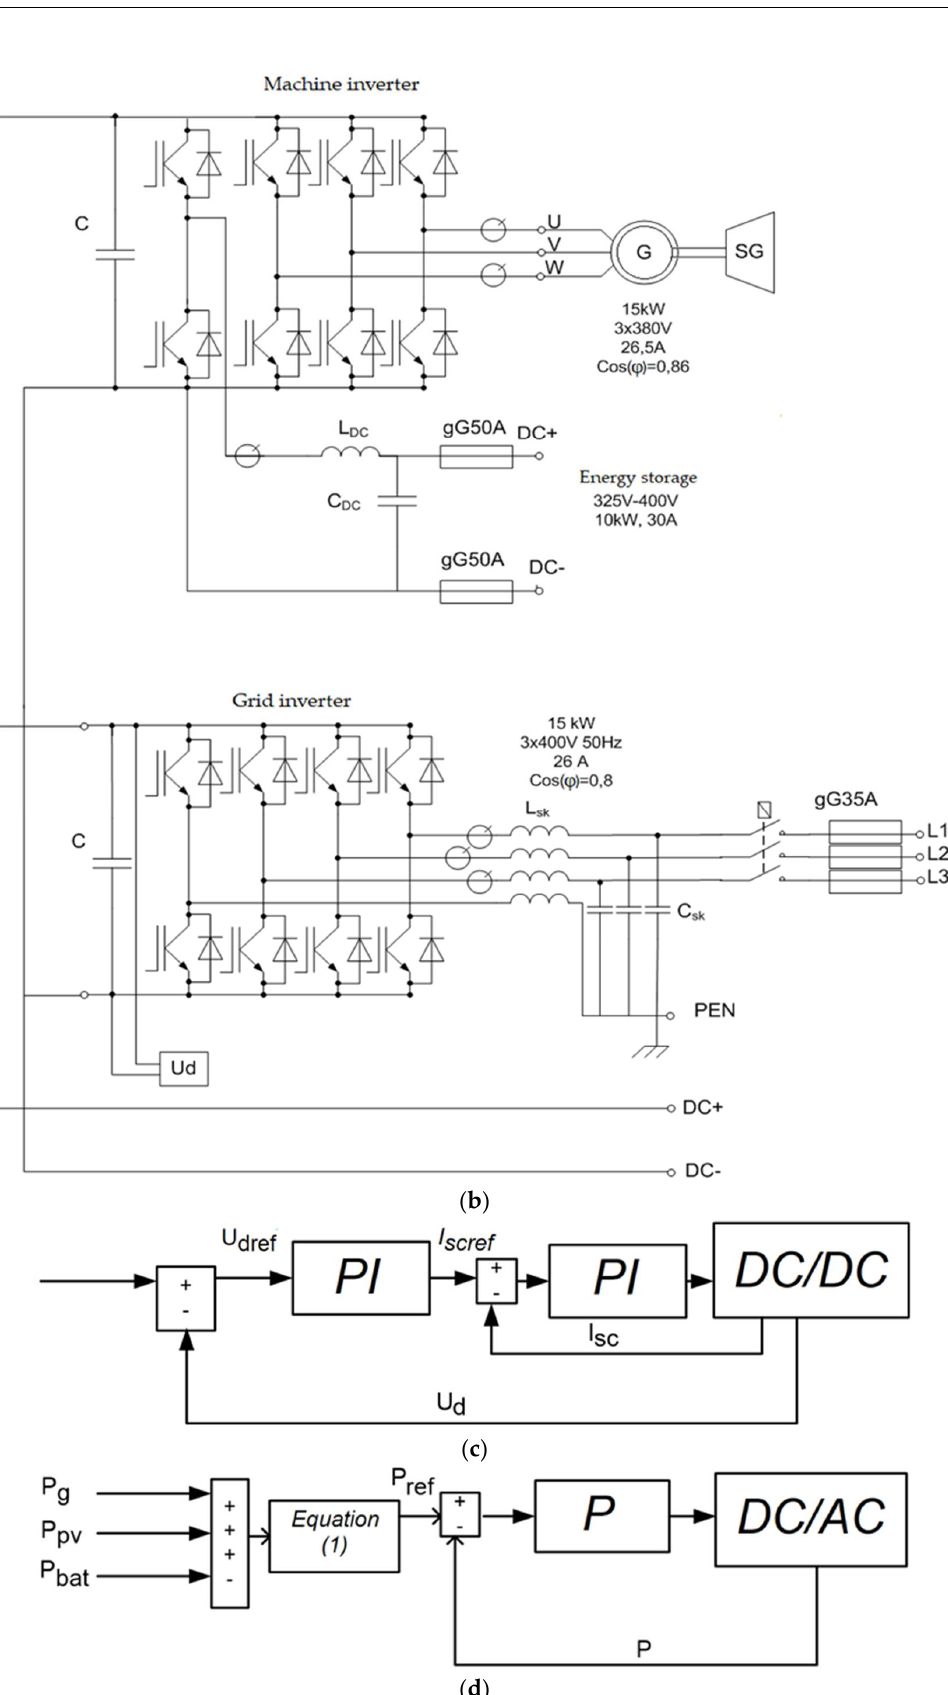
Figure 2. Scheme of the ( a ) microgrid, ( b ) inverters, ( c ) DC bus control system, and ( d ) grid inverter power control